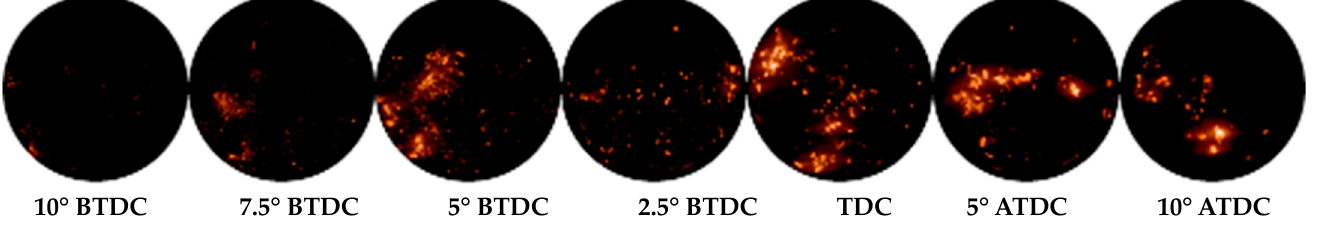
Figure 3. Visible images at 2000 rpm and injection pressure fixed at 700 bar.